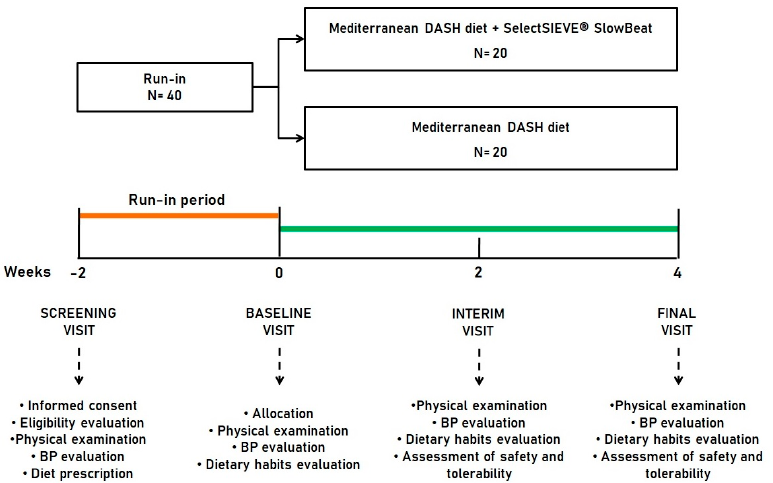
Figure 1. Study timeline. BP = Blood pressure; DASH = Dietary Approaches to Stop Hypertension; N = Number of individuals.